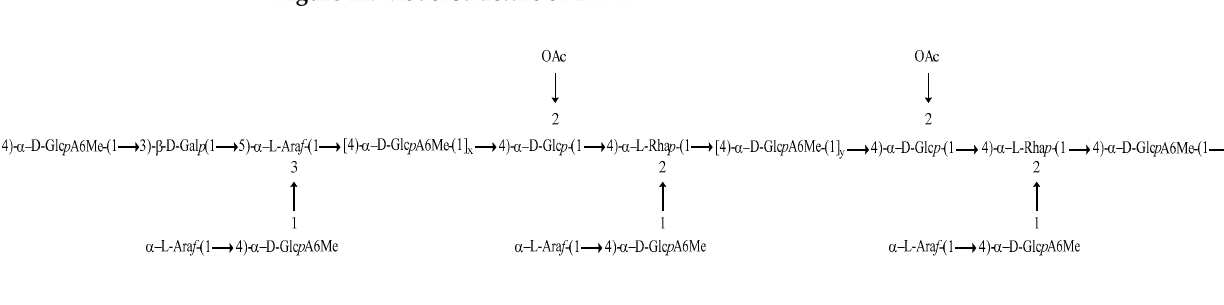
Figure 12. Model structure of LFP-1.